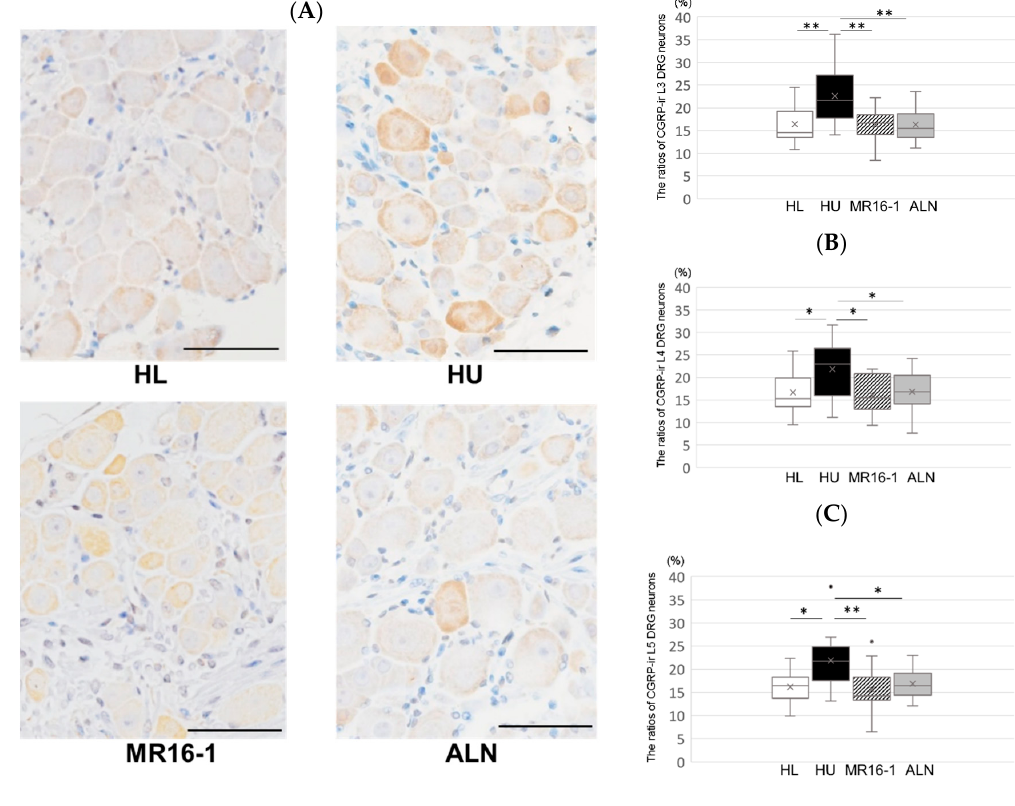
Figure 2. Immunohistochemical analysis of Calcitonin gene-related peptide (CGRP) expression in dorsal root ganglion (DRG) neurons: ( A ) CGRP expression in the DRG neurons (Scale bar is 50 µ m). The ratios of CGRP-immunoreactive L3 ( B ), L4 ( C ), and L5 ( D ) DRG neurons (%). Top, bottom, and middle lines of the graph correspond to the 75th percentile, 25th percentile, and median, respectively. Cross represents mean. Each circle represents an outlier ( n = 8 in each group). * p < 0.05 and ** p < 0.01.